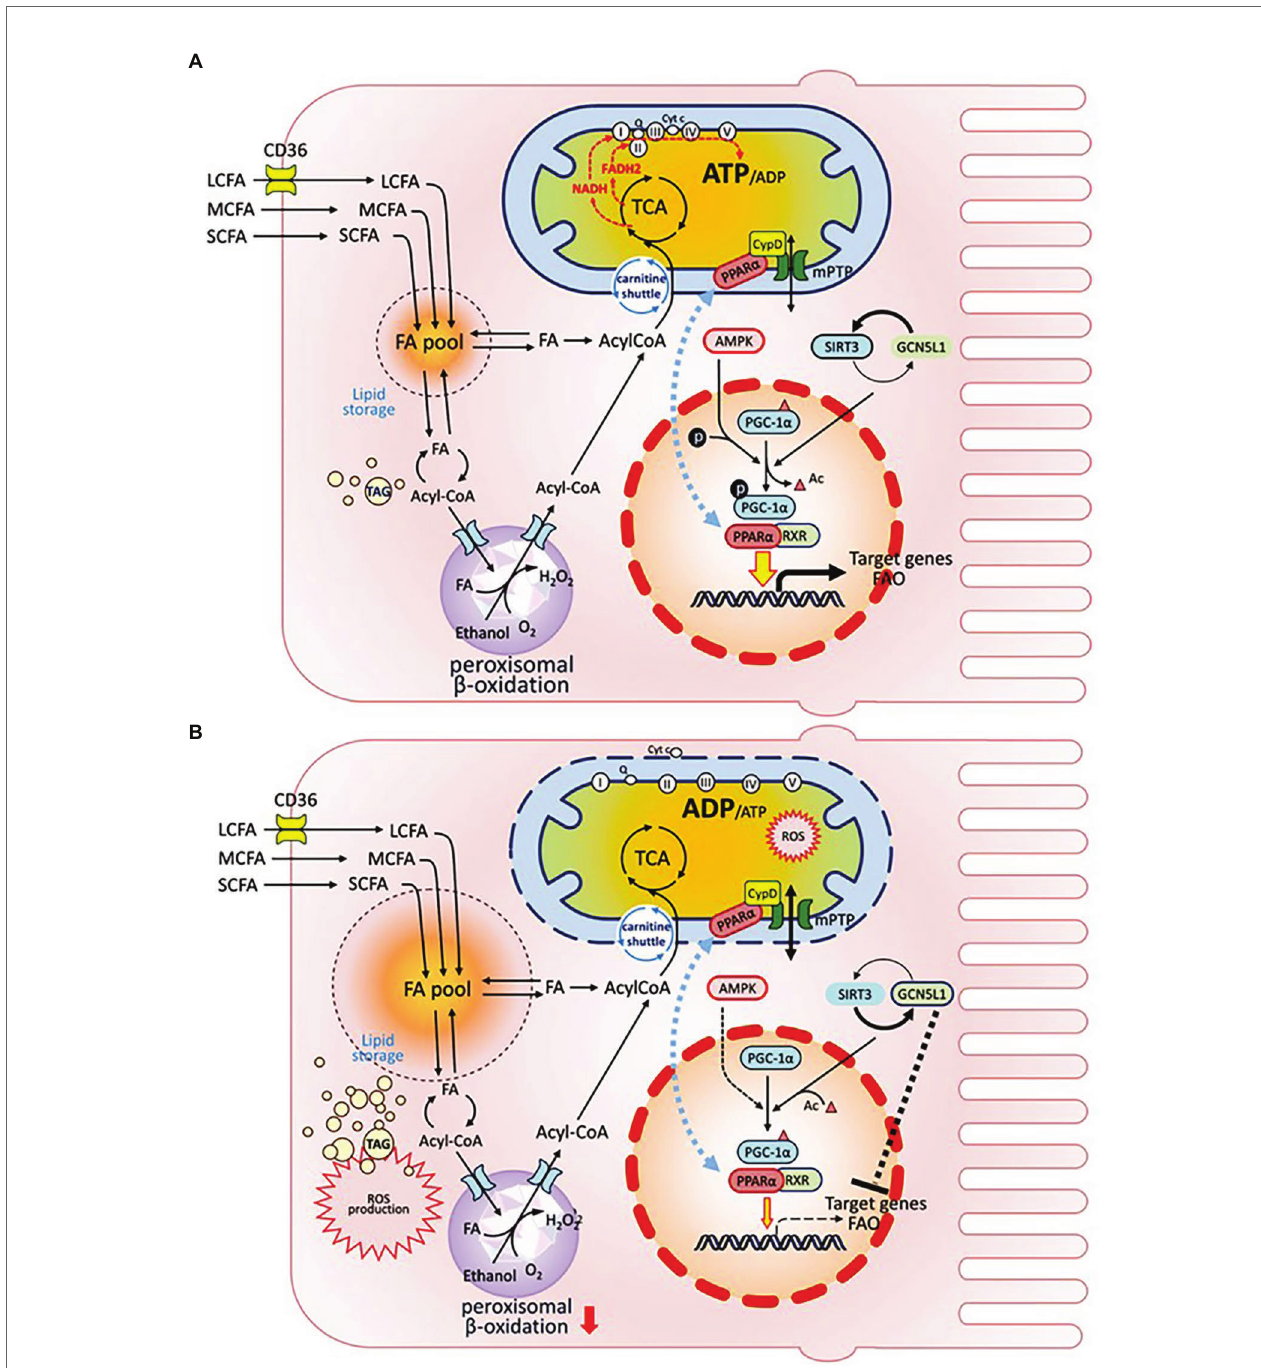
FIGURE 2 | Organelle crosstalk regulates fatty acids metabolism in renal PTEC under healthy or injury/disease states. Intracellular FA metabolism includes catabolic and anabolic pathways. FAs are oxidized either in mitochondria or peroxisome to generate ATP (catabolism), or are stored as global triglyceride pool (anabolism). PGC-1 α is the mitochondrial master regulator, which drives mitochondrial biogenesis by co-activating transcriptional factors PPAR- α and RXR to regulate the expression of target genes affecting biogenesis, OXPHOS, and FAO. PGC-1 α is also extensively regulated by post-translational modifications: PGC-1 α is activated via phosphorylation by AMPK; its acetylation state is regulated by the counter-balance between SIRT deacetylase and GCN5L1 acetylase. GCN5L1 activation also negatively modulates FAO target genes. Translocation of PPAR α between nucleus and IMM affects PPAR α activity as a transcription factor. (A) In healthy condition. (B) Under injury/disease state, impaired PGC-1 α leads to defective FAO and is associated with reduced FA catabolism, increased FA pool and TAG accumulation, increased cellular ROS production, and PPAR α mitochondrial translocation, which induces PPAR α interaction with CypD, mPTP opening, ETC disruption, cytochrome C release, and mitochondrial